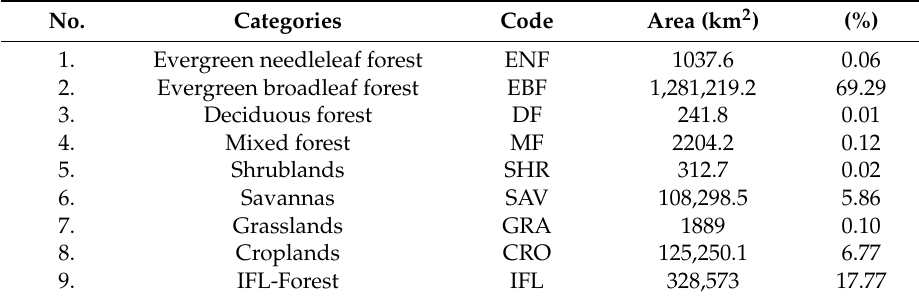
Table 1. Vegetation cover types based on MODIS MOD12Q1 Type 2 UMD categories combined with IFL data for